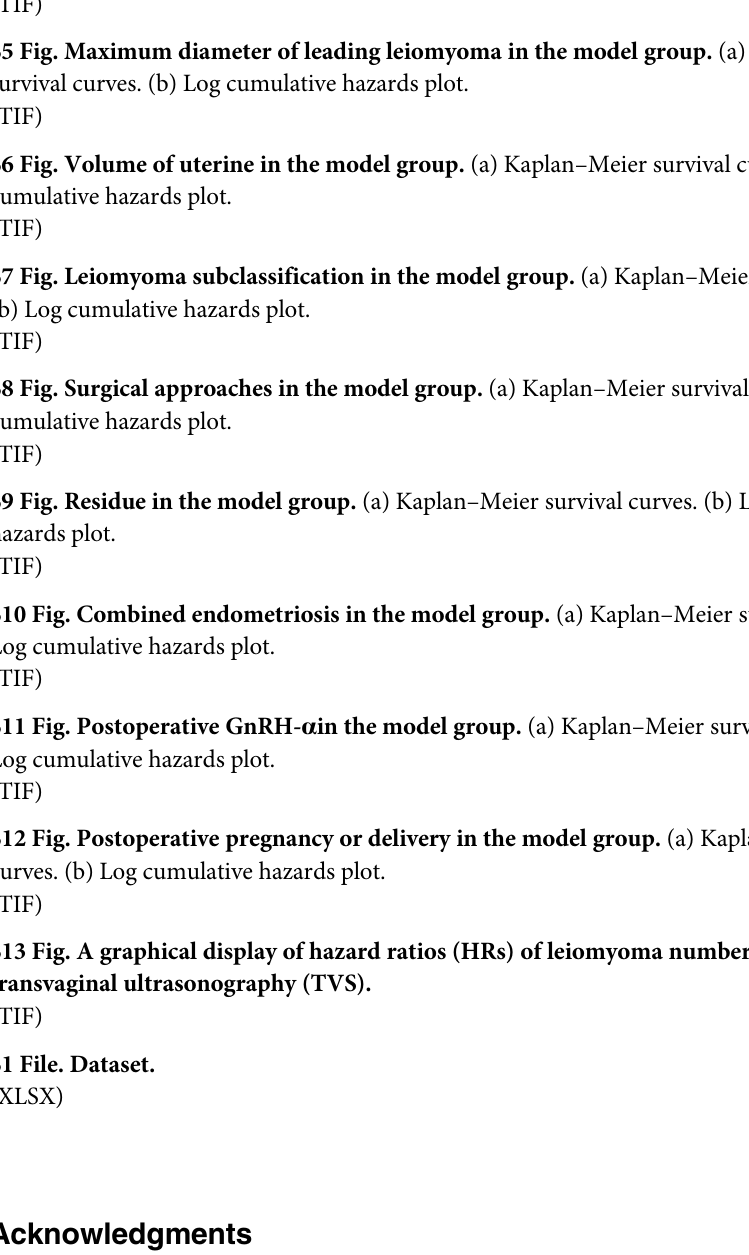
S3 Fig. Age at surgery in the model group. (a) Kaplan–Meier survival curves. (b) Log cumula- tive hazards plot. (TIF) S4 Fig. Leiomyoma number on transvaginal ultrasonography in the model group. (a) Kaplan–Meier survival curves. (b) Log cumulative hazards plot. (TIF) S5 Fig. Maximum diameter of leading leiomyoma in the model group. (a) Kaplan–Meier survival curves. (b) Log cumulative hazards plot. (TIF) S6 Fig. Volume of uterine in the model group. (a) Kaplan–Meier survival curves. (b) Log cumulative hazards plot. (TIF) S7 Fig. Leiomyoma subclassification in the model group. (a) Kaplan–Meier survival curves. (b) Log cumulative hazards plot. (TIF) S8 Fig. Surgical approaches in the model group. (a) Kaplan–Meier survival curves. (b) Log cumulative hazards plot. (TIF) S9 Fig. Residue in the model group. (a) Kaplan–Meier survival curves. (b) Log cumulative hazards plot. (TIF) S10 Fig. Combined endometriosis in the model group. (a) Kaplan–Meier survival curves. (b) Log cumulative hazards plot. (TIF) S11 Fig. Postoperative GnRH- α in the model group. (a) Kaplan–Meier survival curves. (b) Log cumulative hazards plot. (TIF) S12 Fig. Postoperative pregnancy or delivery in the model group. (a) Kaplan–Meier survival curves. (b) Log cumulative hazards plot. (TIF) S13 Fig. A graphical display of hazard ratios (HRs) of leiomyoma number obtained by transvaginal ultrasonography (TVS). (TIF) S1 File. Dataset.